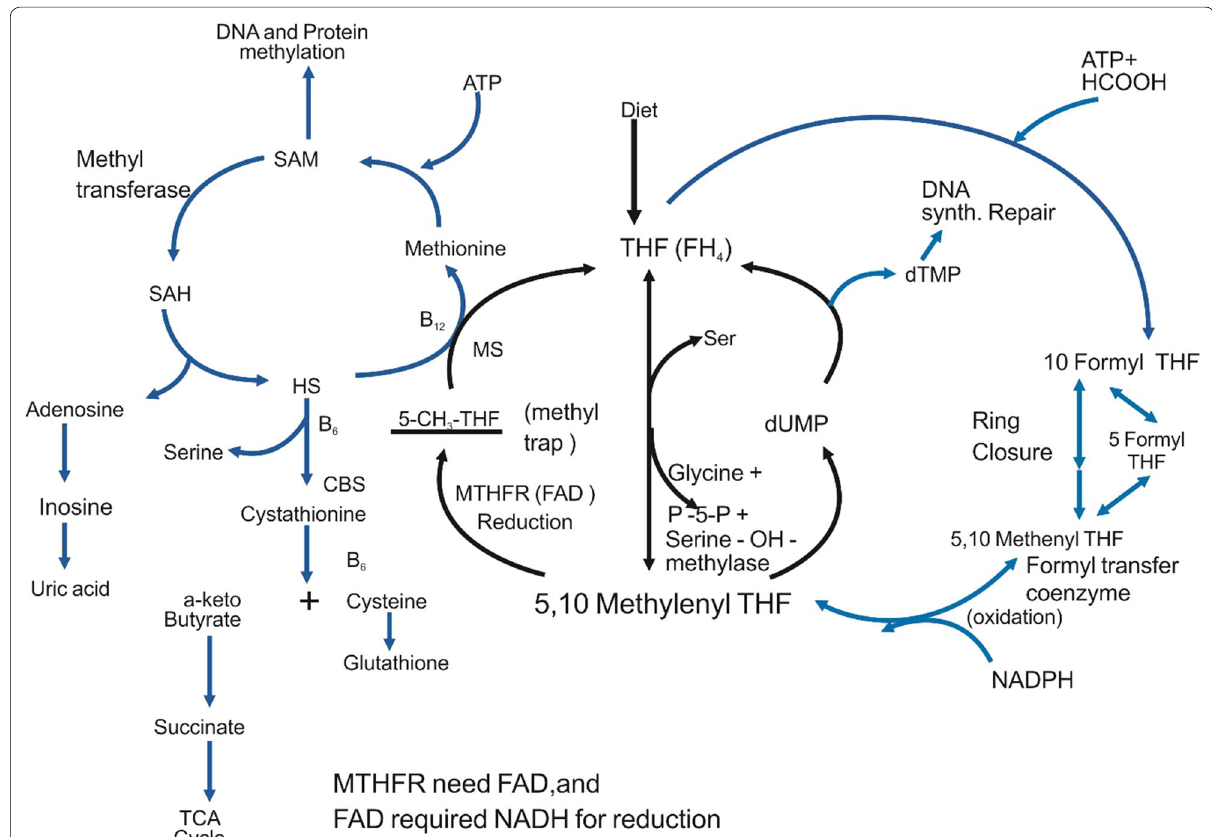
Fig. 2 Metabolism of folate and its relationship with methionine. The key donor (SAM) is synthesized from methionine and is used to transfer a methyl group in DNA and the protein methylation cycle. Once a methyl group is transferred, it will change into S -adenosyl homocysteine, which further becomes homocysteine, and then methionine. Methyltetrahydrofolate (THF) and vitamin B 12 are required as key regulatory cofactors. FAD, flavin adenine dinucleotide; NADPH, nicotinamide adenine dinucleotide